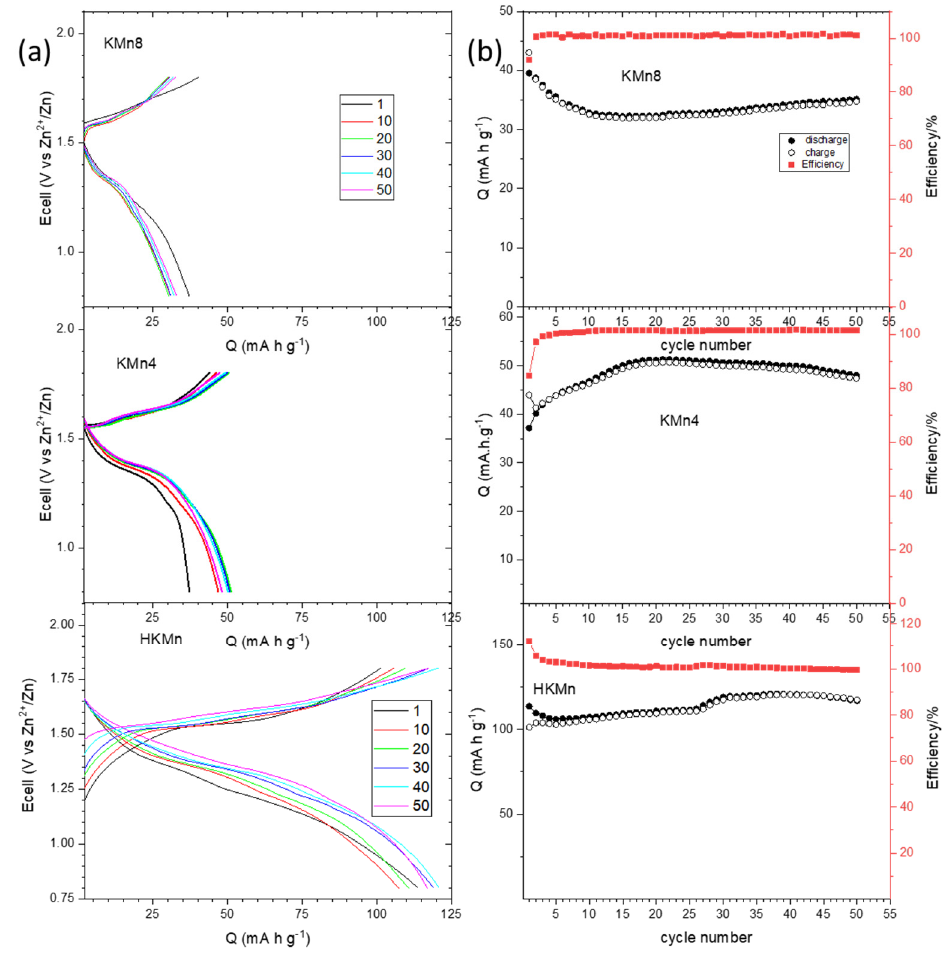
Figure 7. ( a ) Charge–discharge profiles at 300 mA g − 1 and ( b ) Specific capacity and efficiency for KMn8, KMn4 and HKMn during 50 cycles.